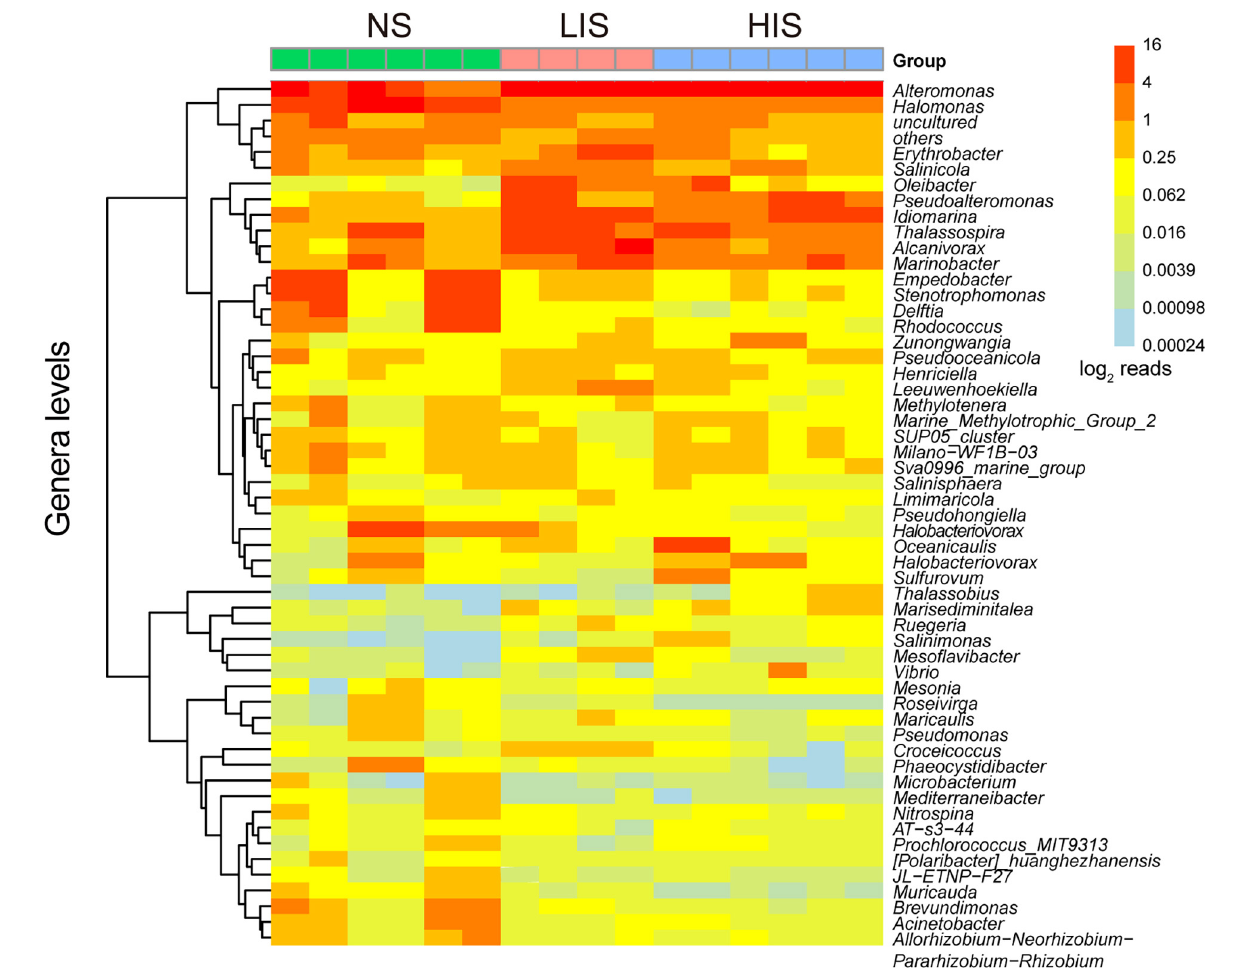
FIGURE 3 | Heatmap based on the 52 most abundant genera at the three sites. The log 2 value of the taxa read number is indicated by the color gradient from light blue (low) to red